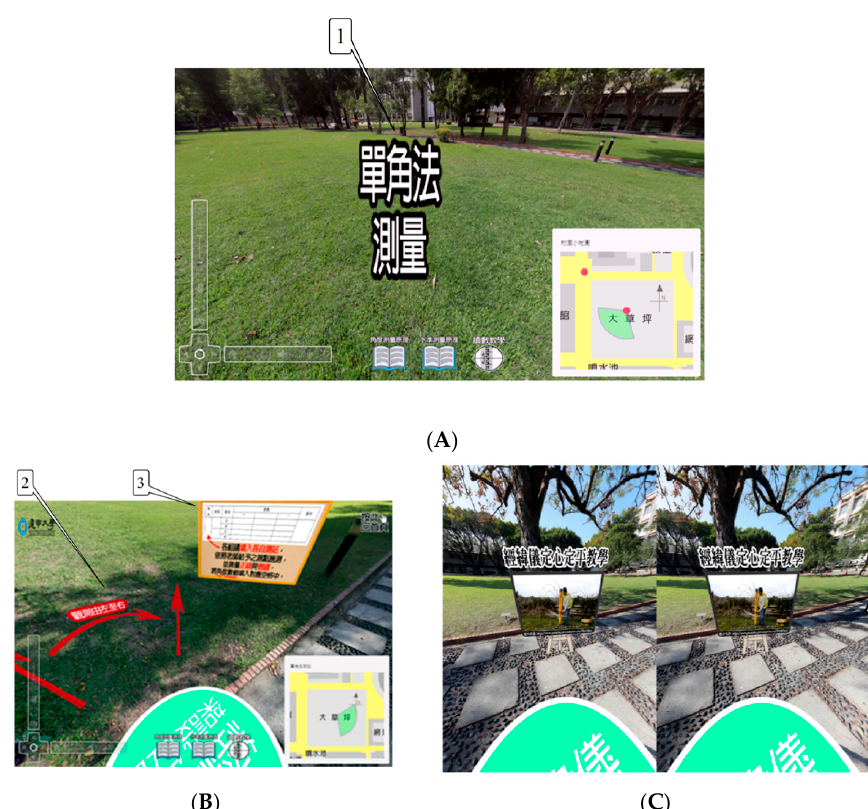
Figure 11. Webpage for teaching the elevation-based measurement. ( A ) Entrance for angle-based measurement (symbol 1, or called leveling measurement); ( B ) Route selection (symbols 2 and 3 represent routes 1 and 2, respectively); ( C ) Teaching video (symbol 4) for setting up the instrument.